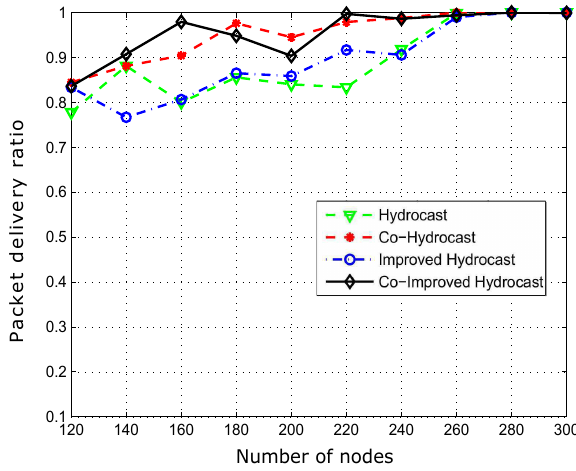
Figure 16. Successfully transmitted data packets to sink.